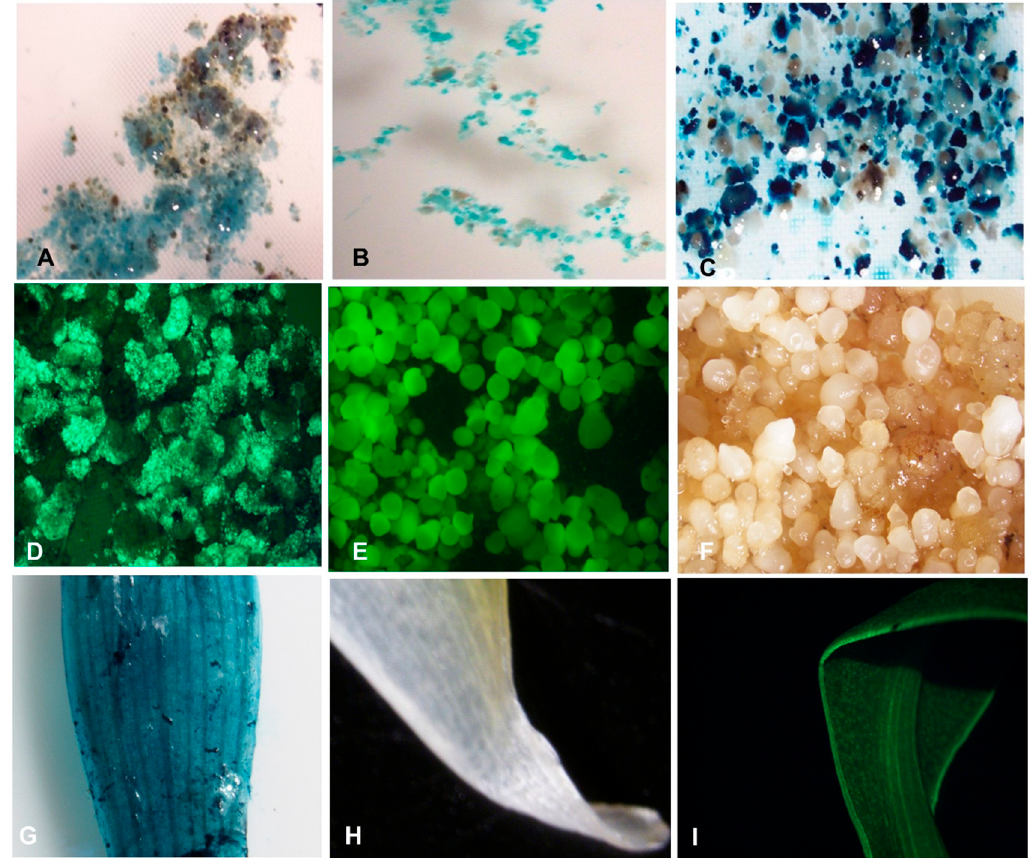
Figure 8. Transient and stable expressions of gusA and gfp in transformed plantain. ( A – C ) Transient expression of gusA gene in Agro -infected embryogenic cell suspension (ECS) of di ff erent cultivars, ( A ) Obino l’Ewai; ( B ) Orishele; ( C ) Agbagba; ( D ) Transient expression of gfp gene in the Agro -infected ECS of Obino l’Ewai; ( E ) Expression of gfp gene in mature embryos of Obino l’Ewai; ( F ) Control non-transformed embryos of Obino l’Ewai; ( G ) Stable expression of gusA gene in leaf explant of the transgenic plant of Obino l’Ewai; ( H ) Control leaf from non-transgenic plant of Obino l’Ewai; ( I ) Stable expression of gfp gene in leaf explant of the transgenic plant of Obino l’Ewai. Photographs ( A – I ) were taken using stereomicroscope (SMZ1500) with 10X magnification.